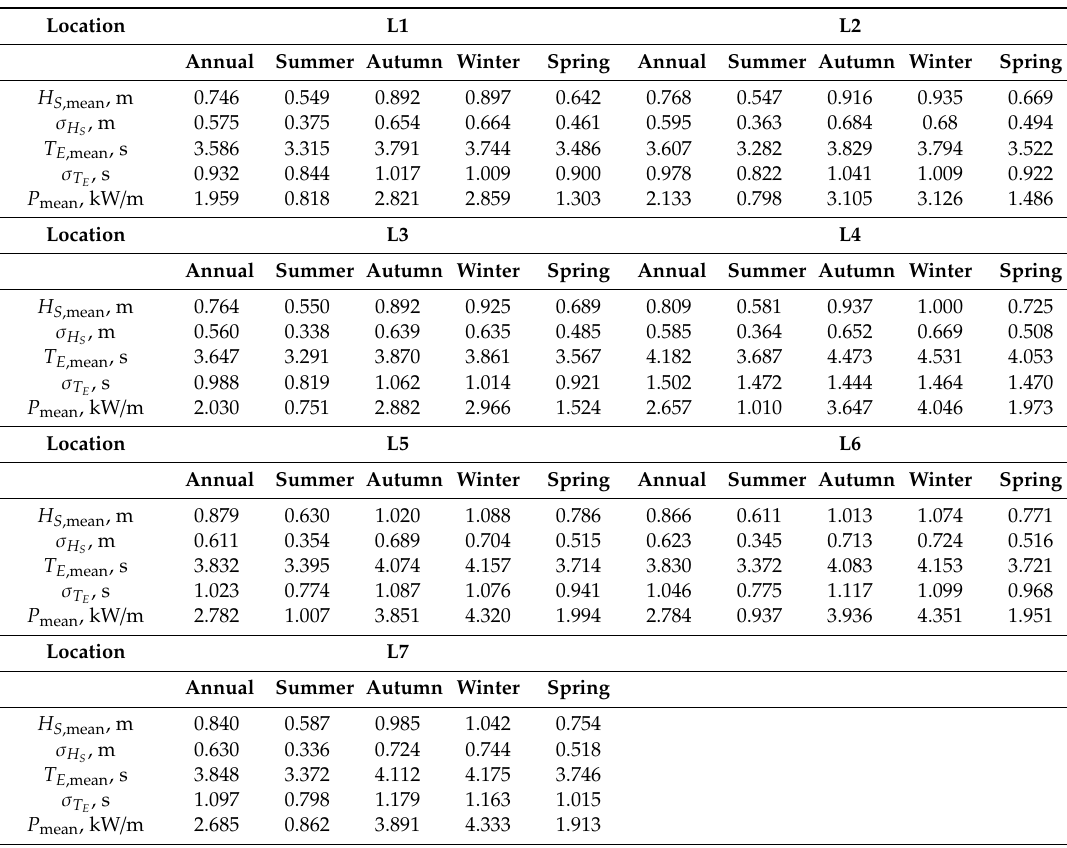
Table 2. Wave climate